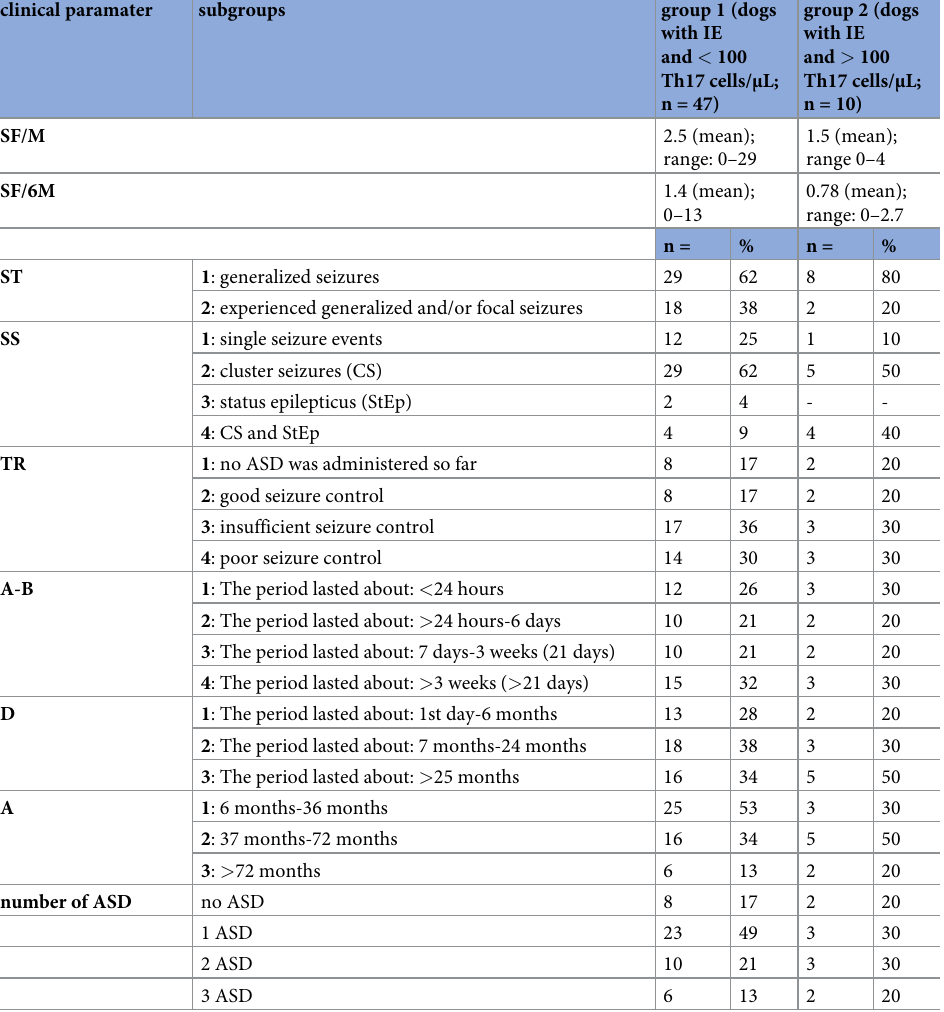
Table 2. Comparison of group 1 (dogs with IE and < 100 Th17 cells/ μ L; n = 47) and group 2 (dogs with IE and > 100 Th17 cells/ μ L; n = 10) in relation to the investigated clinical parameters. clinical